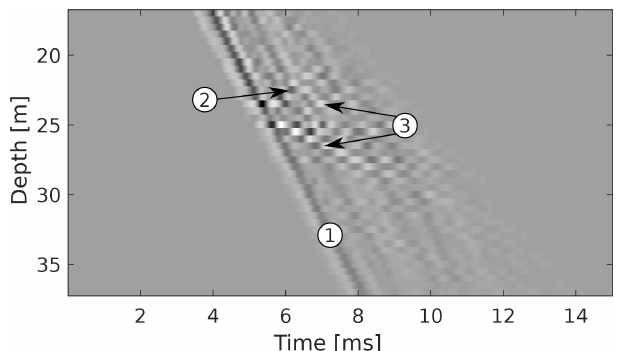
Figure 3. Observed hydrophone VSP data considered in this study. (1) denotes the downgoing P wave, (2) the upgoing tube wave due to the fractures at 23.5 and 23.9m depth, and (3) the up- and downgo- ing tube wave due to the fracture at 25m depth. Note the amplitude decay associated with the P wave.